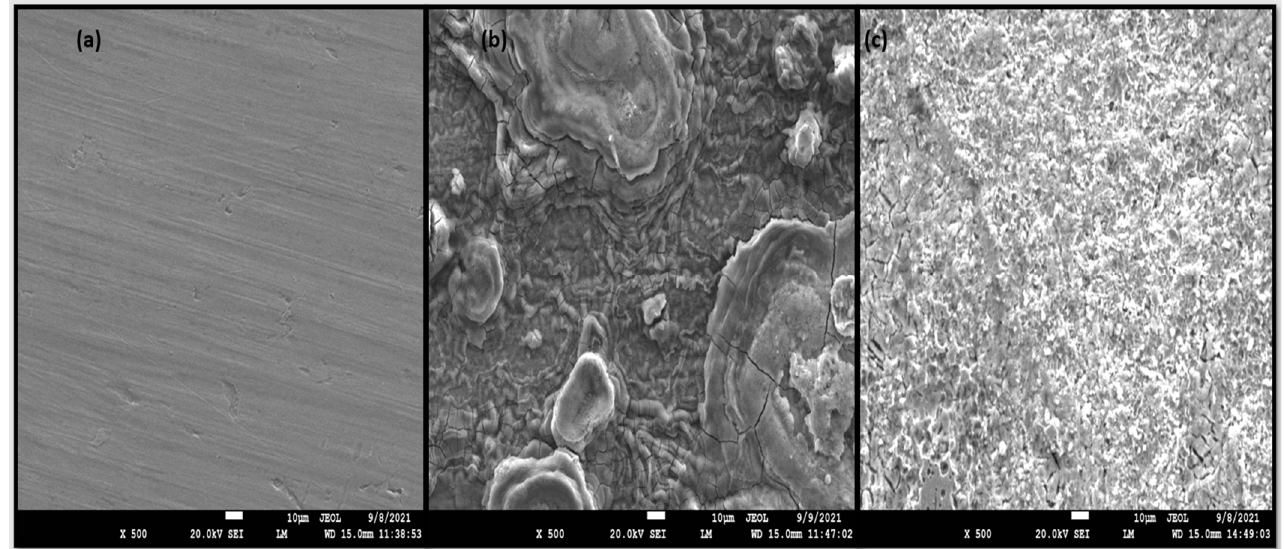
Figure 9. SEM photomicrographs ( a ) polished surface, after immersion in 1 M HCl for 6 h. ( b ) Blank. ( c ) CMEA. ( c ) CMEA.